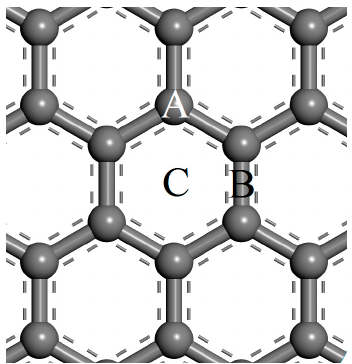
Figure 1. Three adsorption sites of metal atoms on graphene: the Atomic-carbon site (A), Bridge site (B) and Center site (C). (B) and Center site